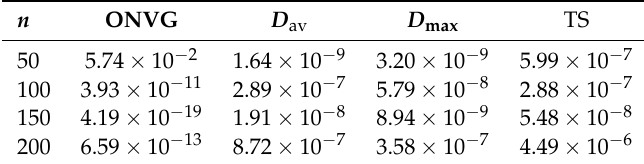
Table 13. The p -values resulting from the t -tests for MOPSO and pccsAMOPSO.